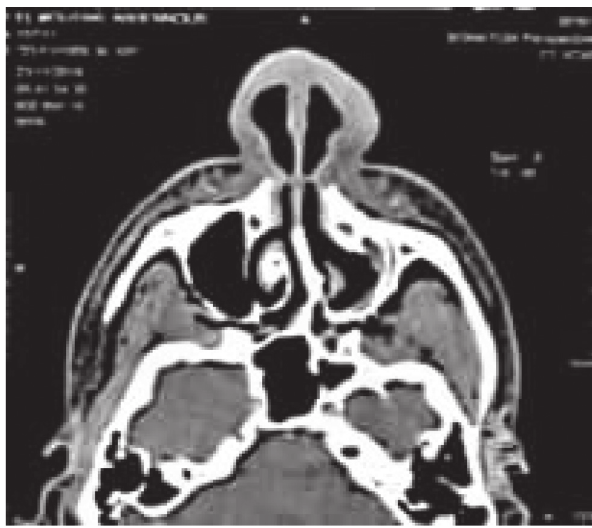
Figure 3: CT scan of the facial mass: no destruction of the nasal septum.